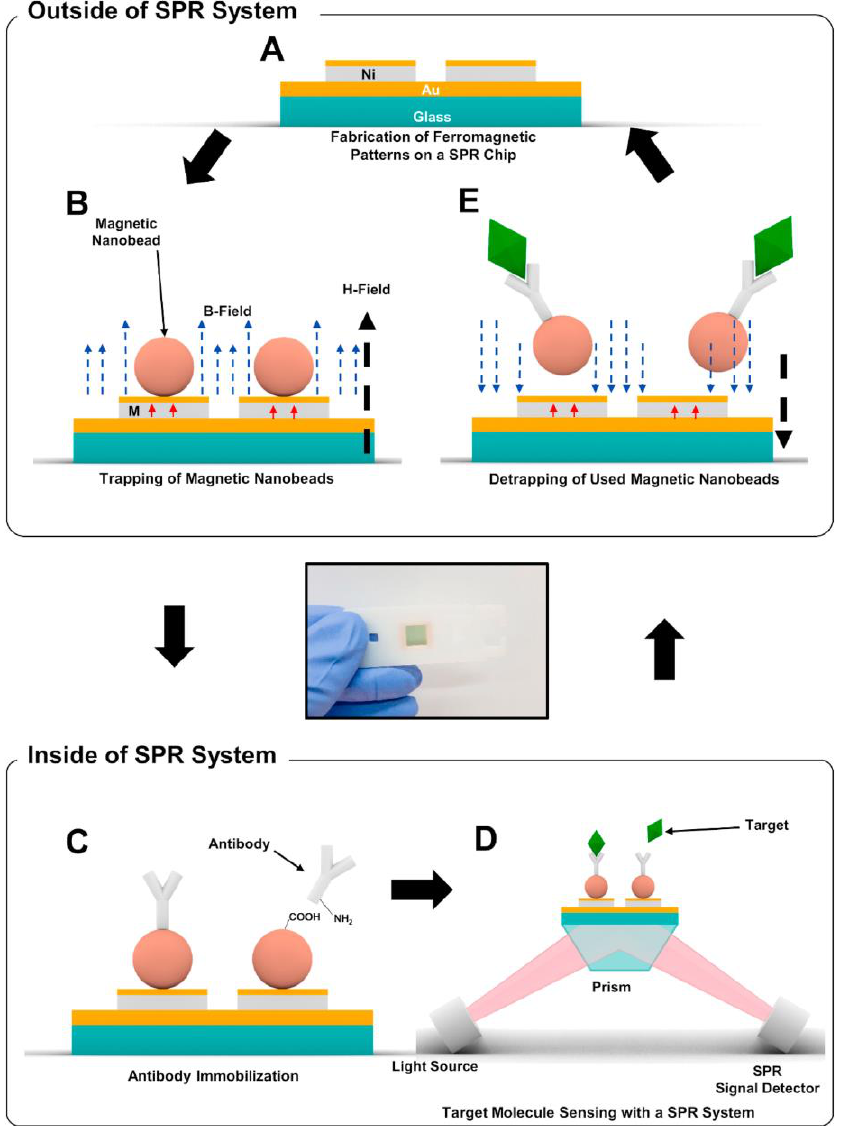
Figure 6. The detection principle of the ferromagnetic patterned SPR sensor chip. ( A ) A reusable SPR chip including ferromagnetic nickel patterns on a conventional SPR chip structure. ( B ) Trapping of magnetic particles on the reusable SPR chip through an external magnetic field. ( C ) Immobilization of antibodies on magnetic particles via EDC-NHS chemistry. ( D ) Detection of target mol- ecules. ( E ) Removal of magnetic particles by applying an external magnetic field in an opposite di- rection to that for trapping. Reproduced from [85] with permission of Elsevier.